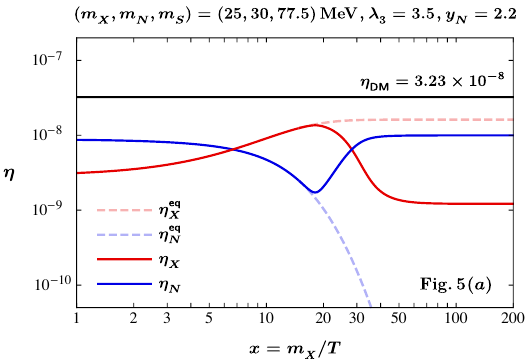
Figure 7 . Cosmological evolution of the dark asymmetries corresponds to benchmark figure 5(a), where the color solid (dashed) curves are actual (equilibrium) DM asymmetries. Figures 5(b), 5(c), and 5(d) have a similar evolution of the dark